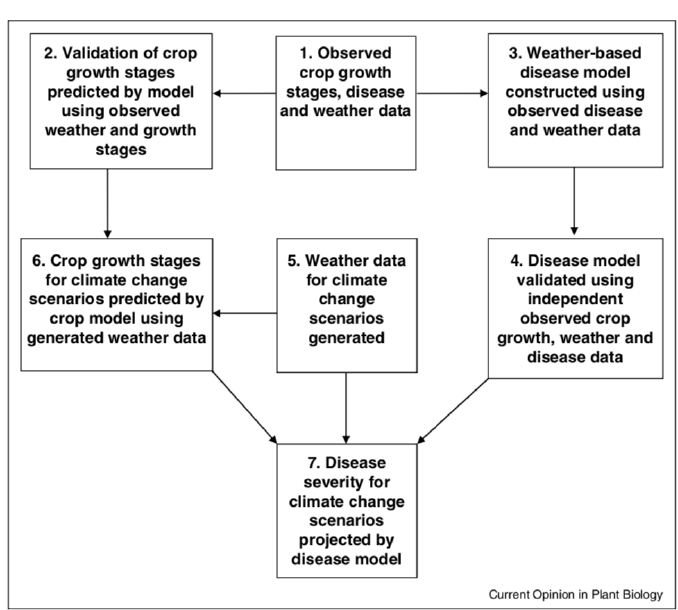
Figure 2. An illustration of how climate, crop growth, and disease models can be combined to produce projections of crop growth stages and disease incidence/severity for different climate change scenarios. Source: